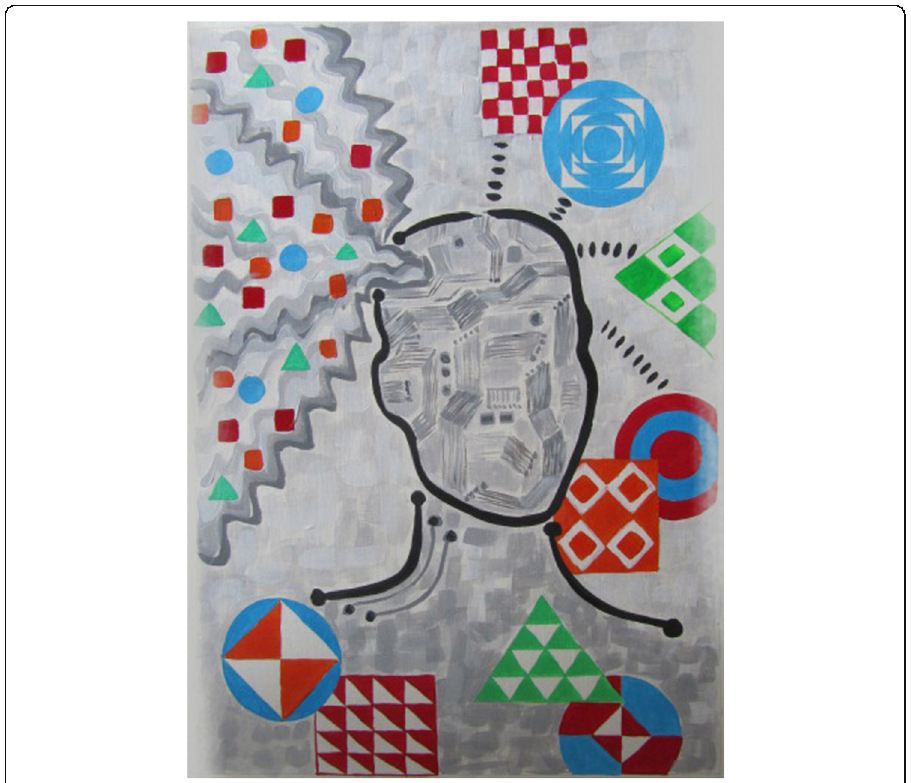
Fig. 2 Creativity and entrepreneurship. By the artist Areti Kamperidis, first published in Journal of Innovation and Entrepreneurship, A SpringerOpen Journal: